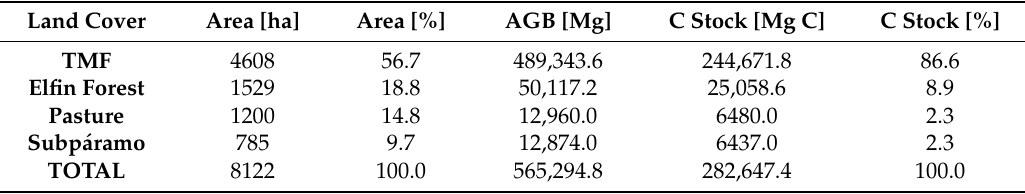
Table 4. Portion of the individual vegetation units respective to the total catchment area, including total AGB and C